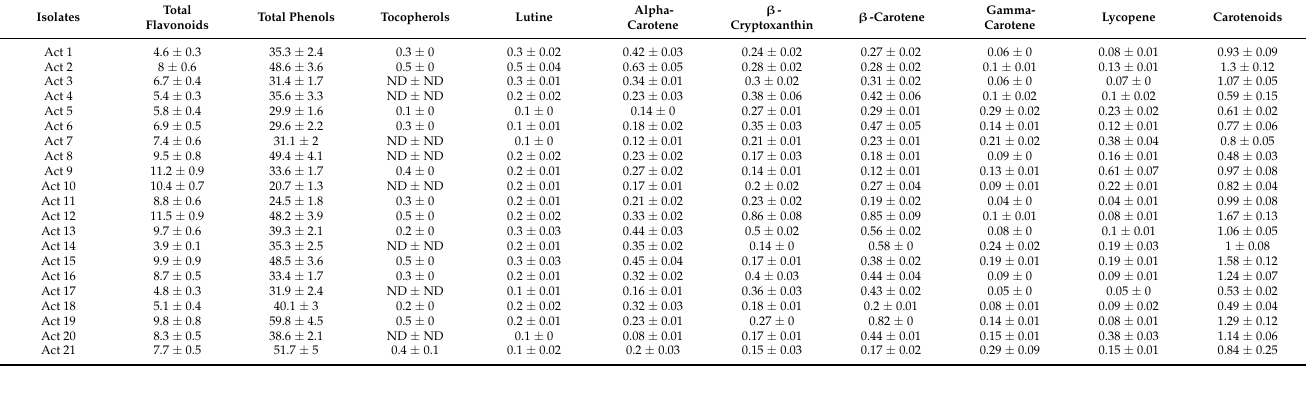
Table 4. The antioxidant phenolic, flavonoids and tocopherols content as well as pigment profile of 21 bacterial isolates. Data are represented by the means of at least 3 replicates ± standard deviations (SD).